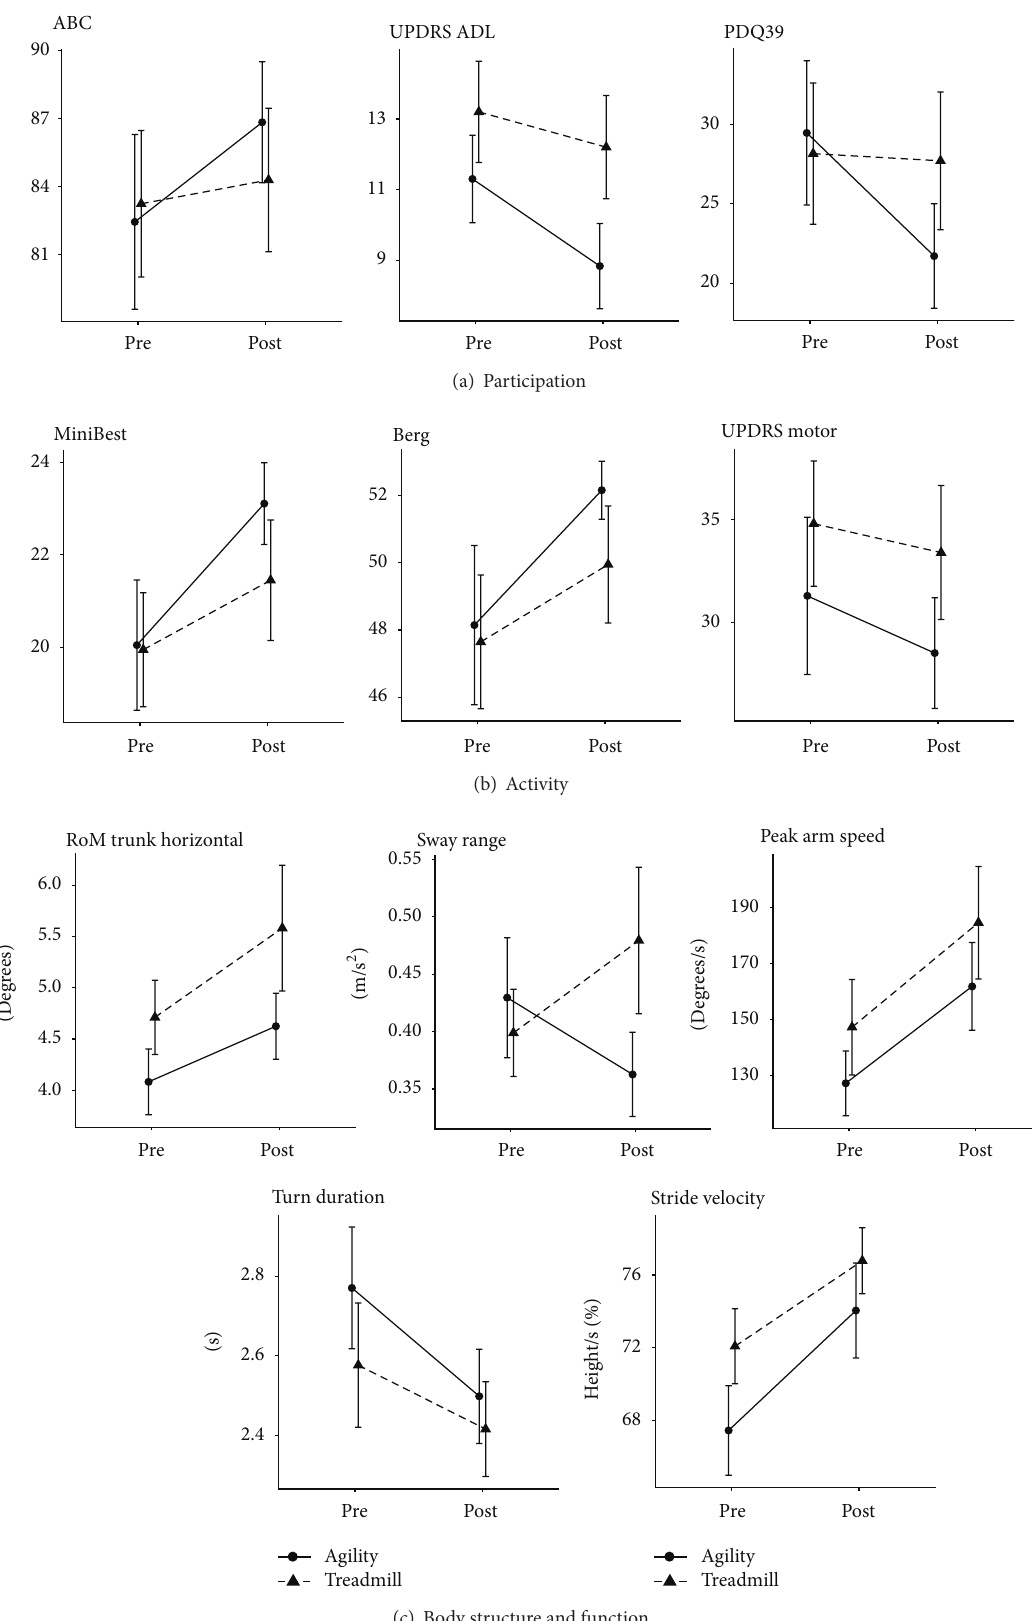
Figure 2: Pre- to Postintervention plots for each exercise group, Agility Boot Camp and treadmill intervention, for each variable according to International Classification of Function and